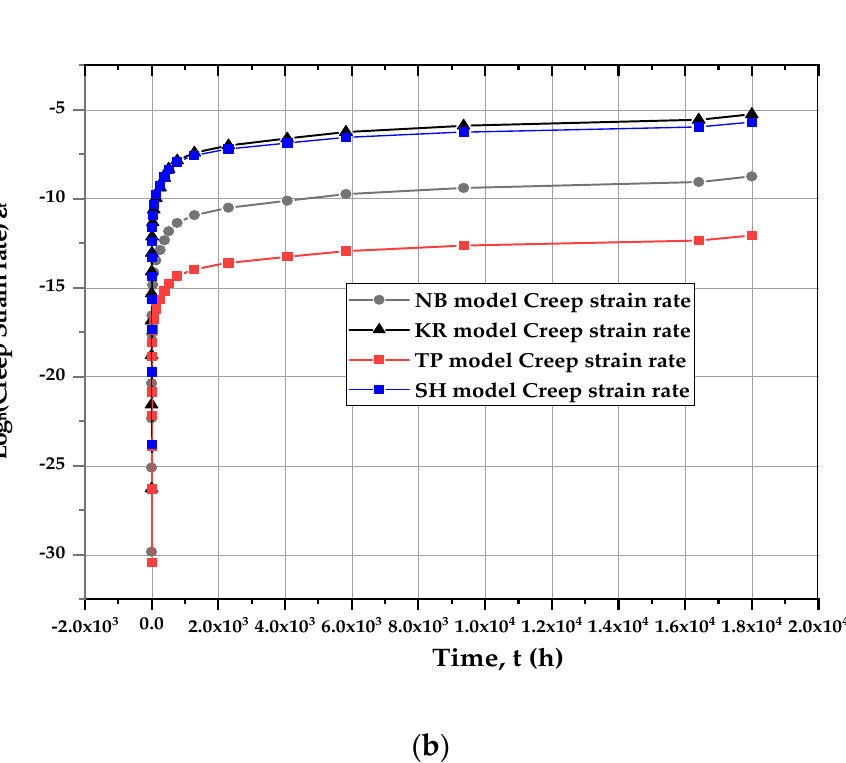
Figure 7. ( a ) Comparison of natural logs of creep strain rates of established models at 720 °C and 60 MPa. ( b ) Comparison of creep strain rates of established models at 720 °C and 60 MPa.